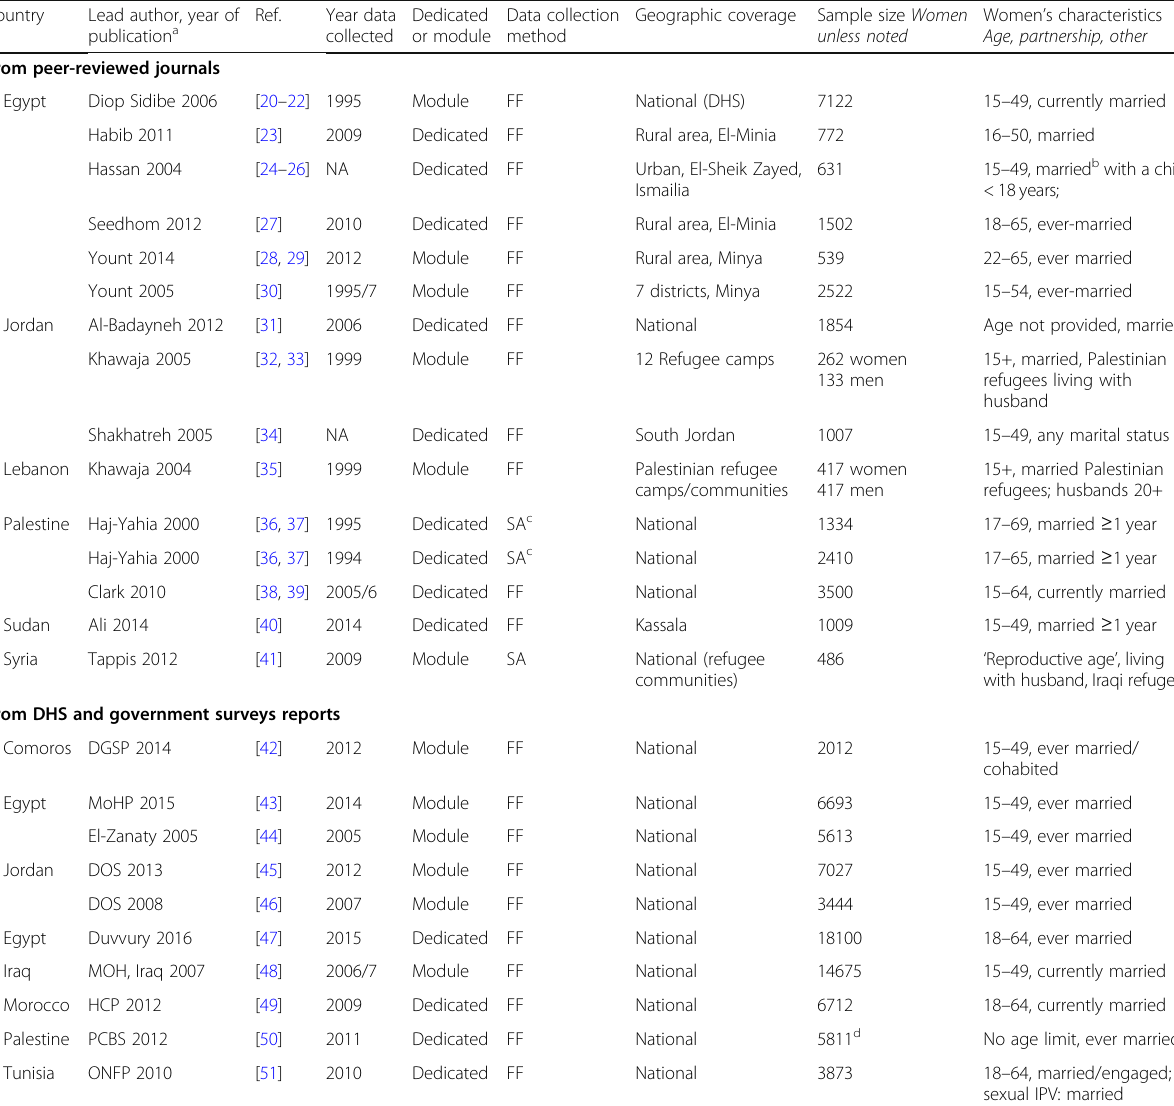
Table 2 Characteristics of population-based , household IPV surveys